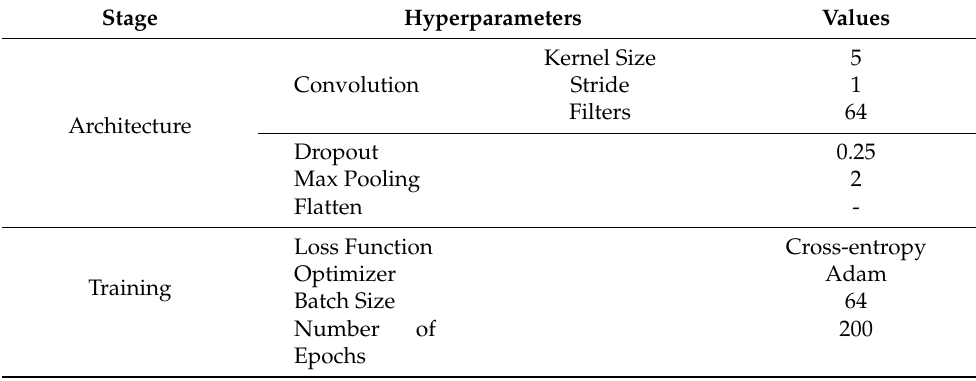
Table A1. The summary of hyperparameters for the CNN network used in this work.